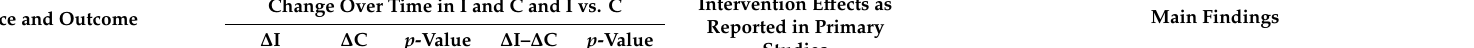
Table 2. Summary of results of school-based interventions targeting nutrition and physical activity, and body weight status of children in African countries. Reference and